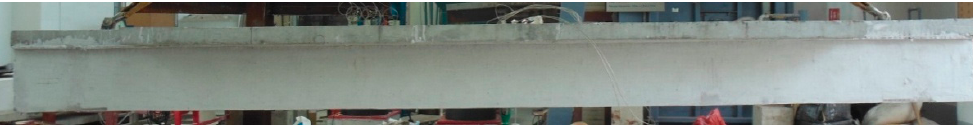
Figure 5. Photo of a specimen before fire test.